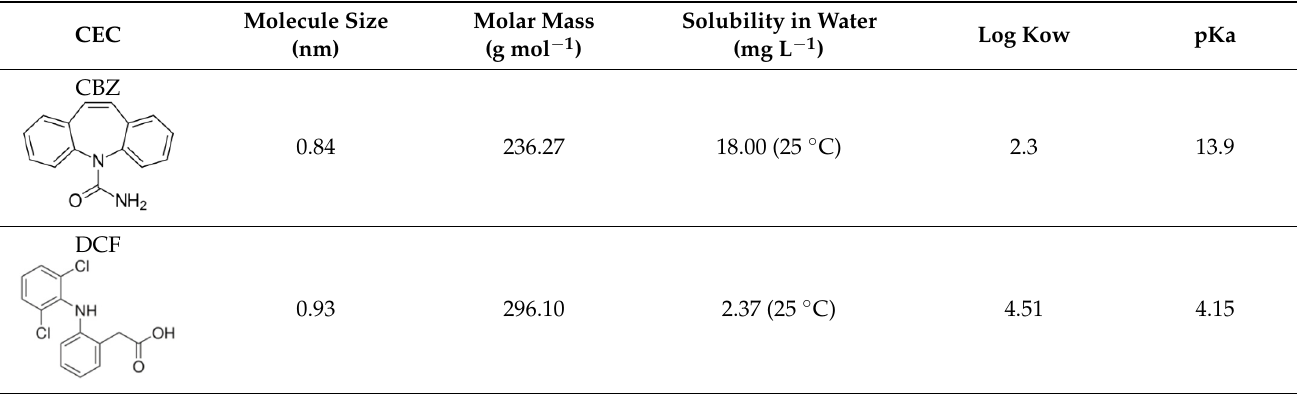
Table 1. Physicochemical characteristics of CBZ and DCF [8].